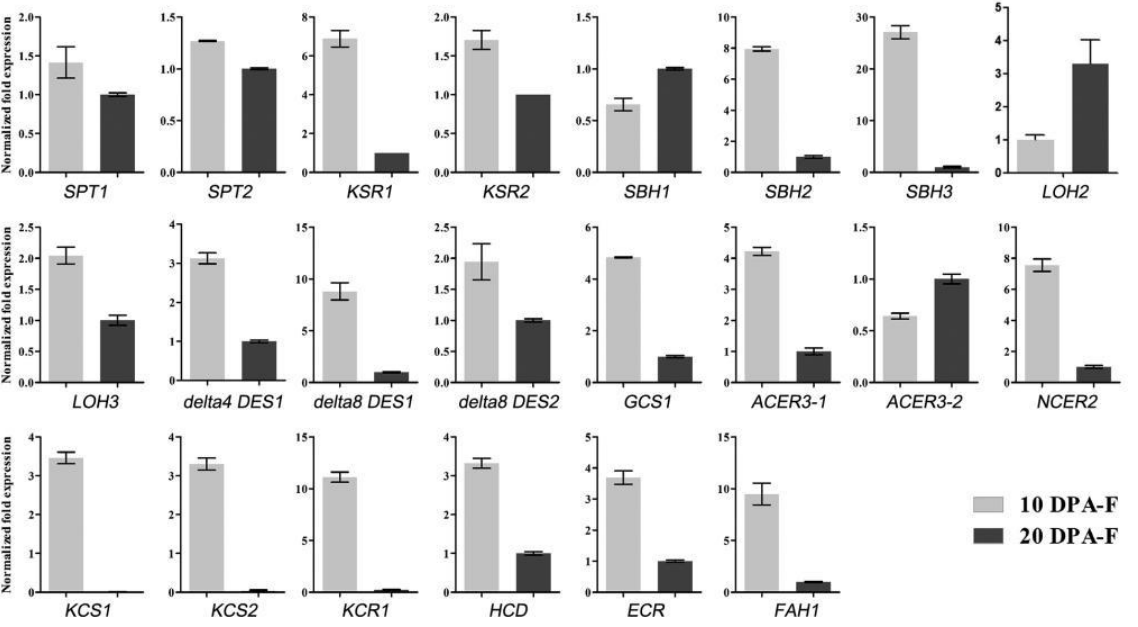
Figure 6. The expression profile of genes involved in sphingolipid biosynthesis and metabolism. SPT1 and SPT2 , serine palmitoyltransfersase ; KSR1 and KSR2 , 3-ketosphinganine reductase ; SBH1 , SBH2 , and SBH3 , LCB C-4 hydroxylase ; LOH2 and LOH3 , ceramide synthase ; delta4 DES1 , LCB delta4 desaturase ; delta8 DES1 and delta8 DES2 , LCB delta8 desaturase; GCS1 , glu- cosylceramide synthase ; ACER3 -1 and ACER3-2 , alkaline ceramidease ; NCER2 , neutral ceramidease ; KCS1 and KCS2 , 3-ketoacyl- CoA synthase ; KCR , 3-ketoacyl-CoA reductase ; HCD , hydroxyacyl-CoA dehydrase ; ECR , enoyl-CoA reductase ; FAH1 , fatty acid 2- hydroxylase . Three independent RNA isolations were used for cDNA synthesis, and each cDNA sample was subjected to quantitative real-time PCR analysis in triplicate. Error bars represent the SD.